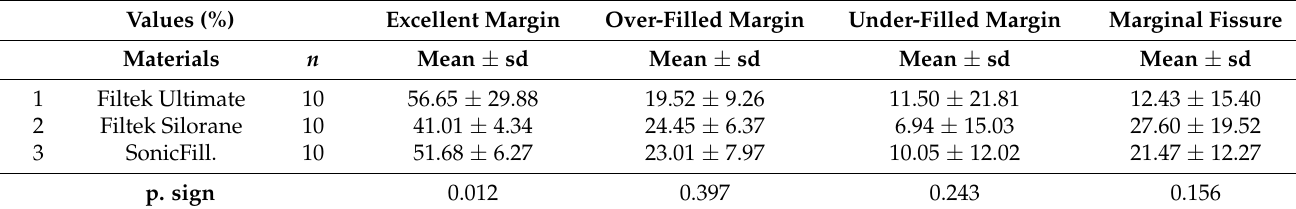
Table 3. Marginal adaptation to the proximal vestibular margin—results.